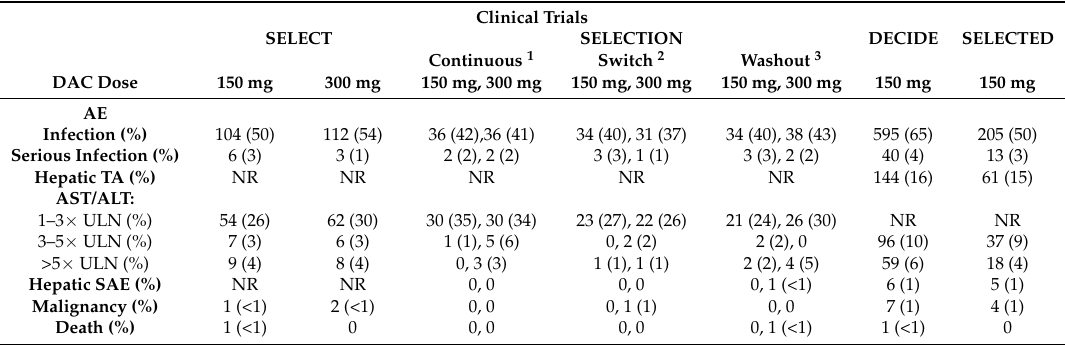
Table 2. Adverse Event Incidence for DAC treated patients in Controlled Trials of DAC